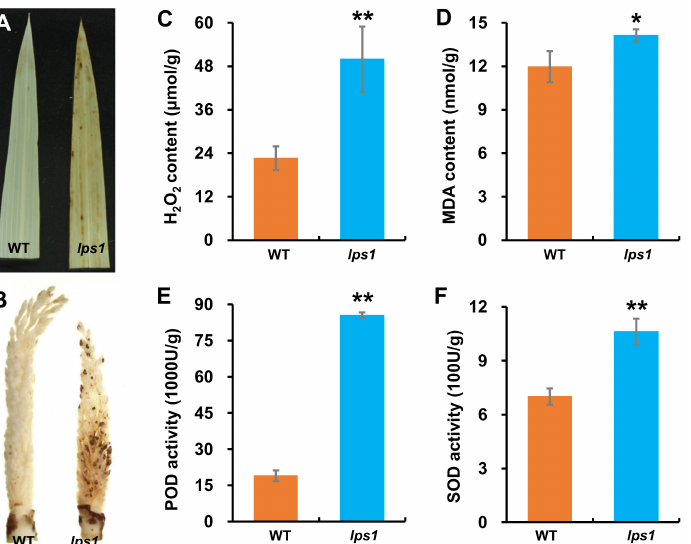
Figure 7. Complementation analysis of lps1 mutant. ( A ) Phenotypes of wild type, lps1 and positive transgenic plant (TP) at grain filling stage. ( B ) Flag leaf of wild type, lps1 and TP plant at heading stage. ( C ) Identification of transgenic plants by PCR and electrophoresis. M: DL-2000 marker; 1-3, 5, 6 and 8–10: positive transgenic plants; 4 and 7: negative transgenic plants; 11: pCAMBIA1300- OsSDH2- 1 plasmid (PCR-positive control); 12: the lps1 mutant (PCR-negative control). ( D ) Identification of transgenic plants by PCR and sequencing. The red arrow indicates the mutation site, showing double peaks in positive transgenic plants. ( E ) Plant height and ( F ) panicle length of wild type, lps1 and TP plant at grain-filling stage. Error bars represent standard deviations of three independent biological replicates. The statistically significant differences were performed by Student’s t test. ** p < 0.01.